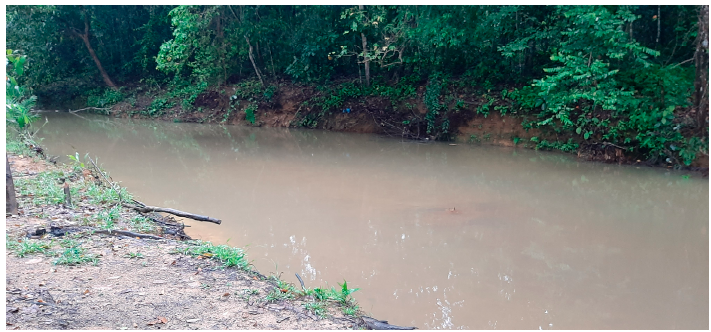
Figure 4. River section of Sg. Berkelah, Pahang was used as the simulation medium. Source: Author.